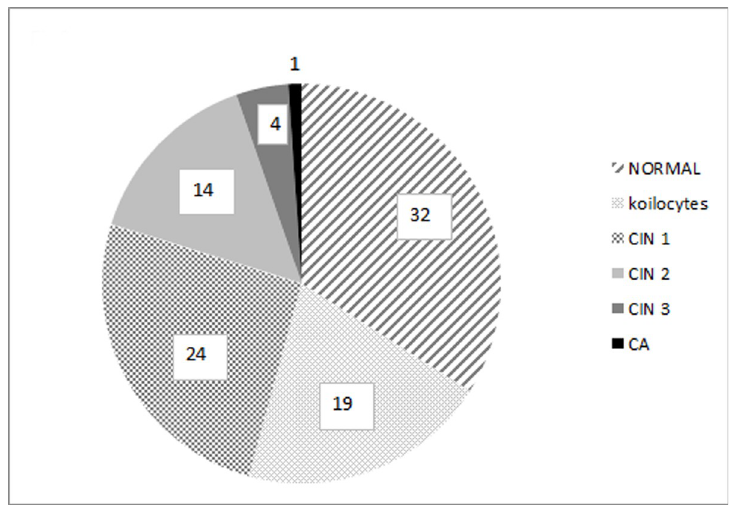
Fig 3. Percentage of normal and abnormal histopathology results in the examined group (n = 94).